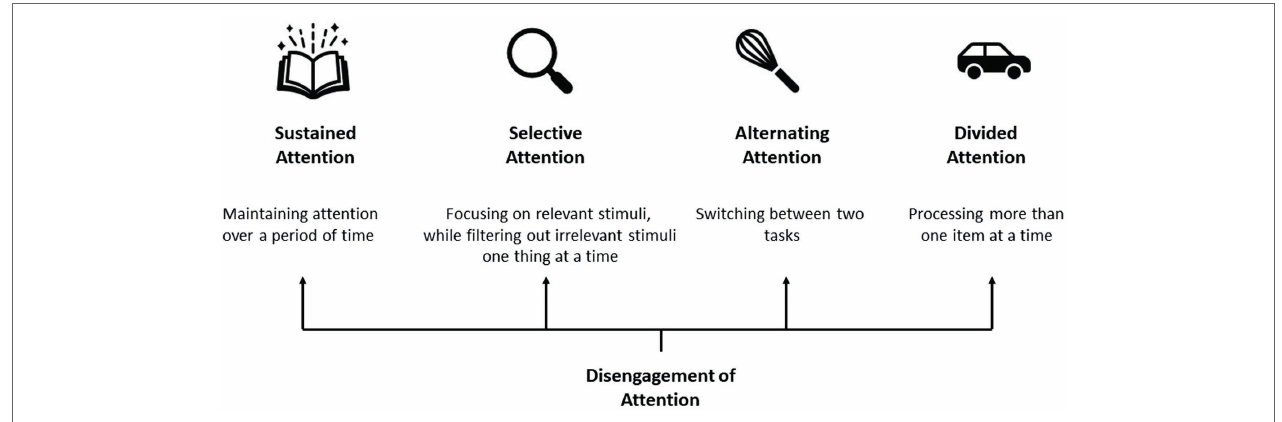
FIGURE 1 | Types of attention and their